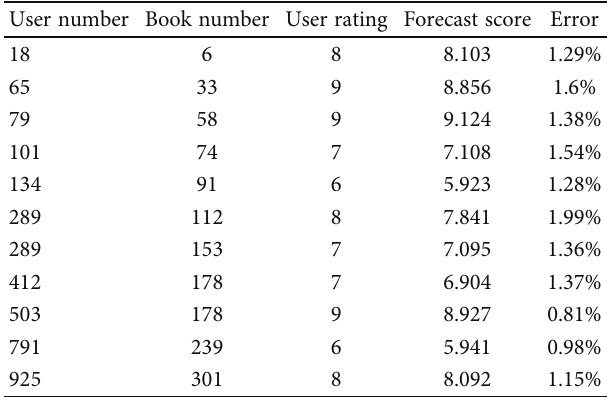
Table 1: Scoring error of ten